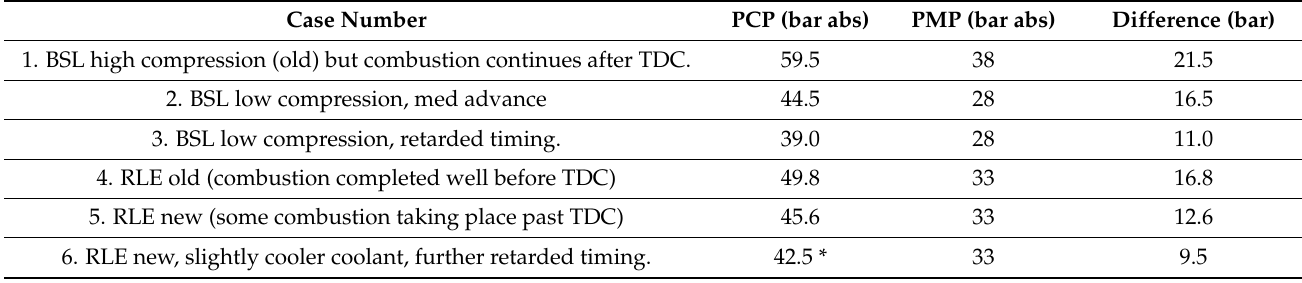
Table 1. Summary of PCP minus PMP for 750 rpm and 71 ◦ C (160F) coolant/oil idle conditions. RLE cases in italics font. Case Number PCP (bar abs) PMP (bar abs)